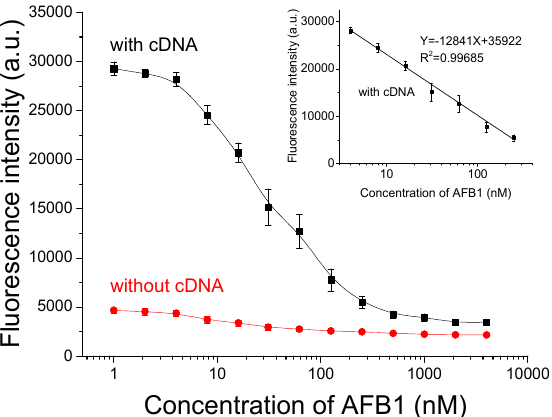
Figure 3. Fluorescence intensities corresponding to different concentrations of AFB1, with or without cDNA assistance. Assay buffer (pH 7.5) containing 20 mM Tris-HCl, 20 mM MgCl 2 , 200 mM NaCl and 0.1% ( v / v ) tween20 was used. MB probe concentration was 20 nM. cDNA concentration was 20 nM. Excitation/emission was 485 nm/518 nm. Incubation was carried out at 4 °C for 20 min.